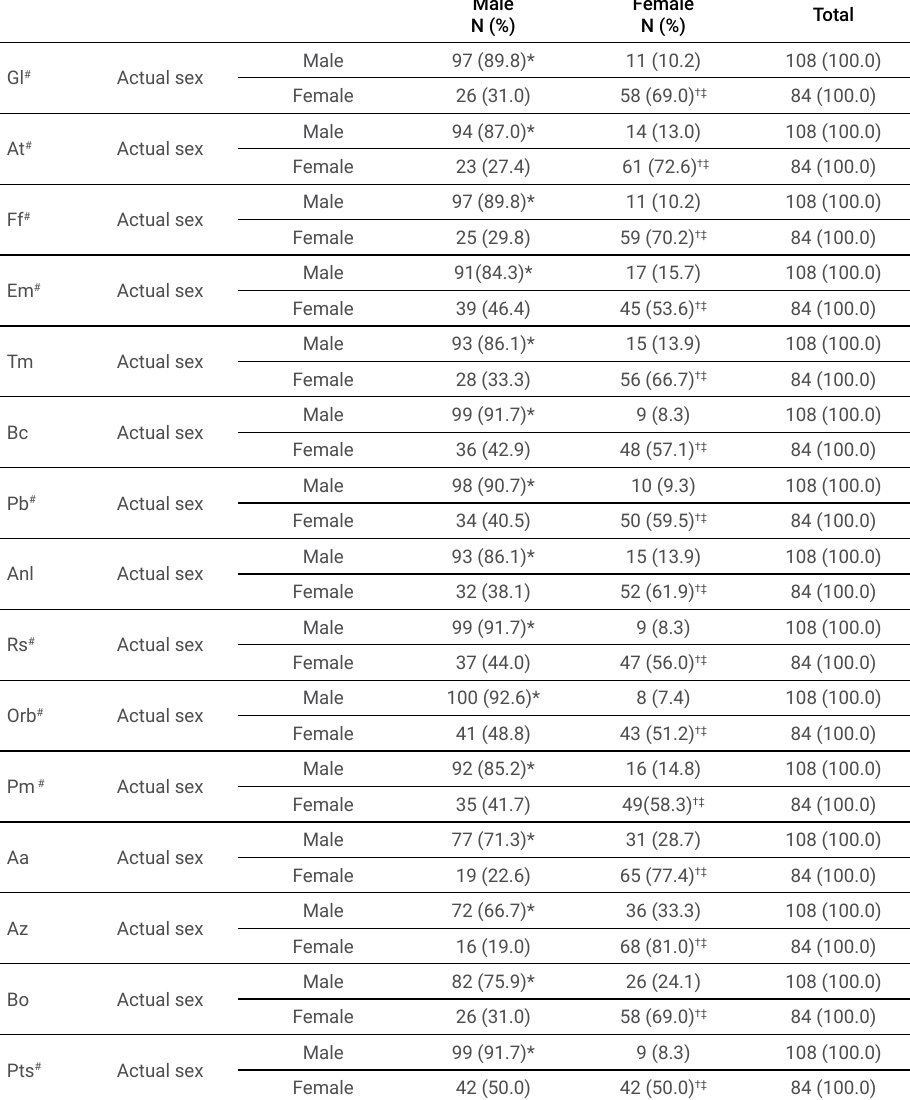
Table 5. The sensitivity, specificity for visual sex classification of the variables that presented moderate and substantial reliability in Cohen’s kappa coefficient (k>0.40;